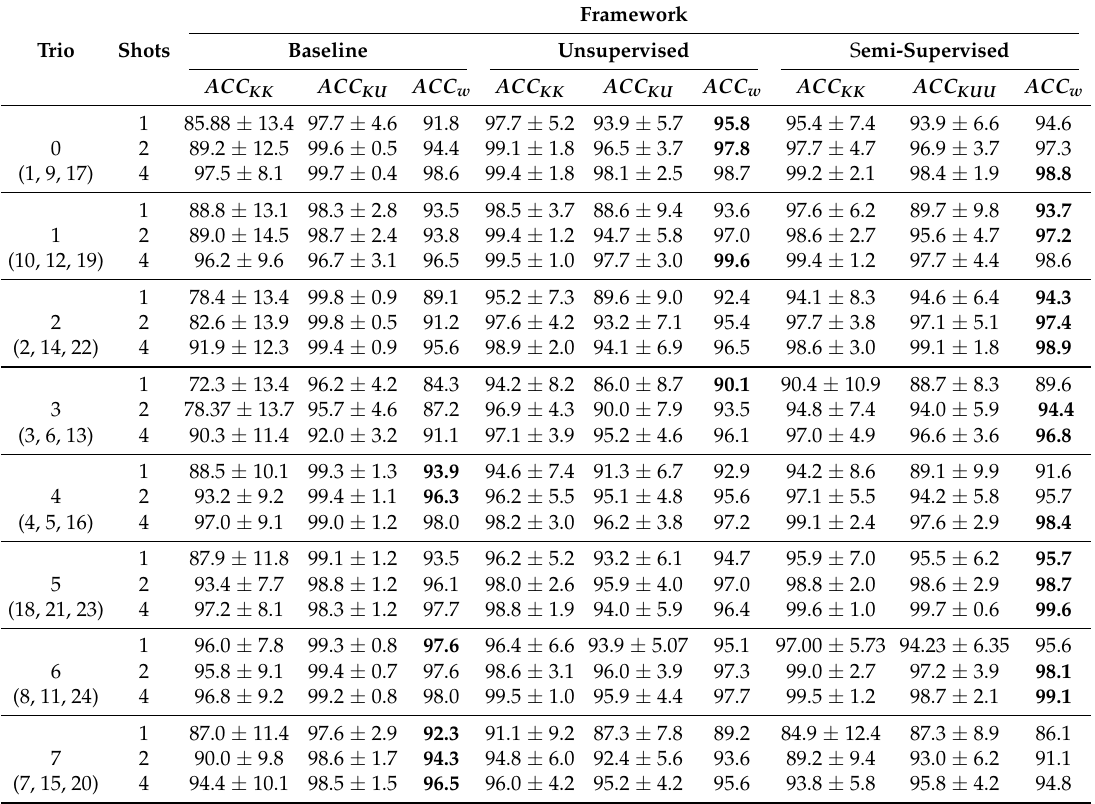
Table 5. Results with trios configuration and O ∗ = 0.13. The number list under the trio number corresponds to the number of patterns that make up that trio. The bold numbers indicate winning configurations according to the number of